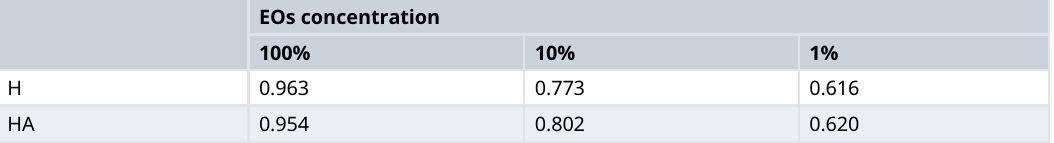
Table 3. Values of reliability. Values of reliability from three replicates of measures of the diameter of inhibitory zone B. subtilis growth (H) and the activity respect to the action of antibiotic Ciprofloxacin (HA) of the 24 EOS at three different